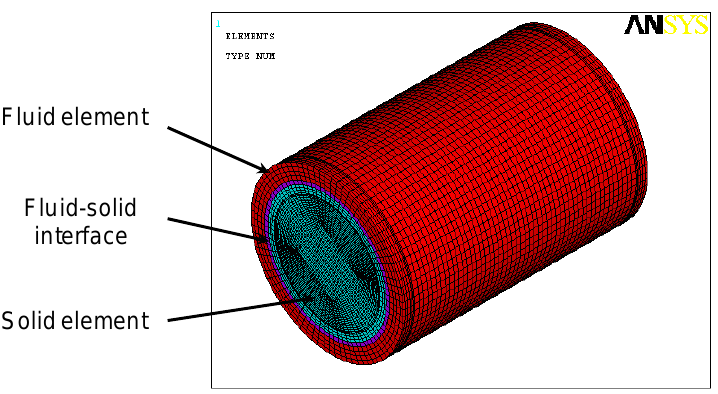
Figure 4. Finite element mesh